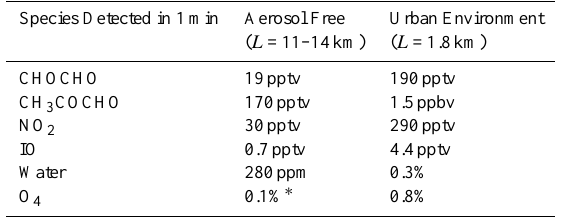
Table 3. Detection Limits (2 σ ) for species in an aerosol free and an urban environment ( ε Mie =5 × 10 − 6 cm − 1 at 450nm). Species Detected in 1min